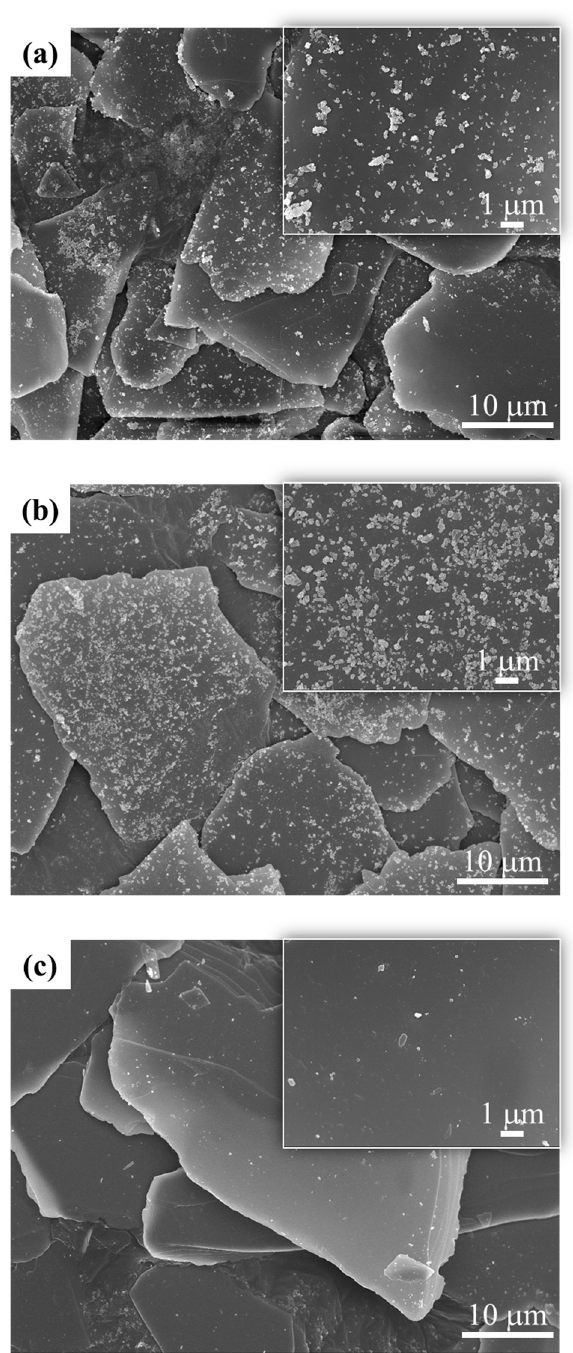
Figure 7. FE-SEM images of Y 2 O 3 :Eu@MF prepared by the variation in Y 2 O 3 :Eu 3+ loading amount, ( a ) 5 wt%; ( b ) 10 wt%; and ( c ) 20 wt% (fixed at pH 8 under 85 °C in H 2 O). ( a ) 5 wt%; ( b ) 10 wt%; and ( c ) 20 wt% (fixed at pH 8 under 85 ◦ C in H 2